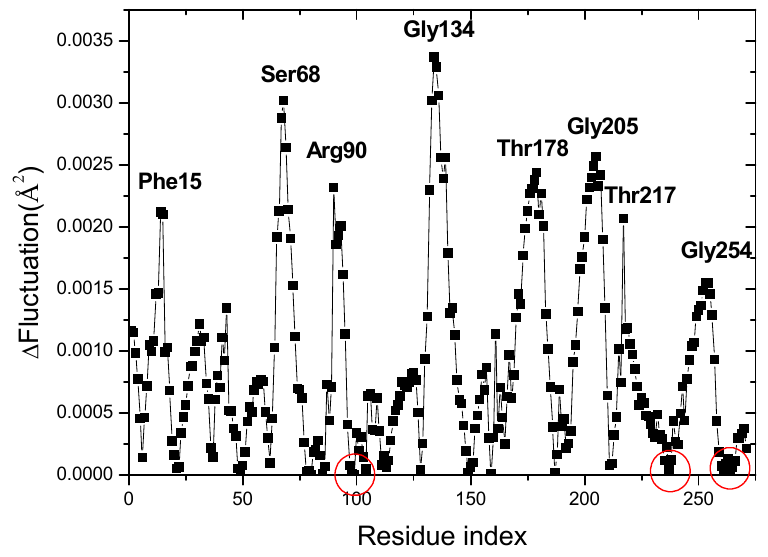
Figure 4. Calculated fluctuation difference between the open-apo and closed-ligand structures using the slowest mode of